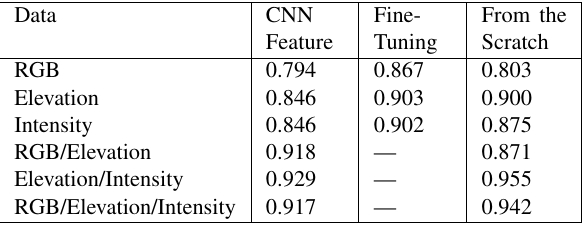
Table 2. Overview of the reached F-Scores for all trainings for each data type and